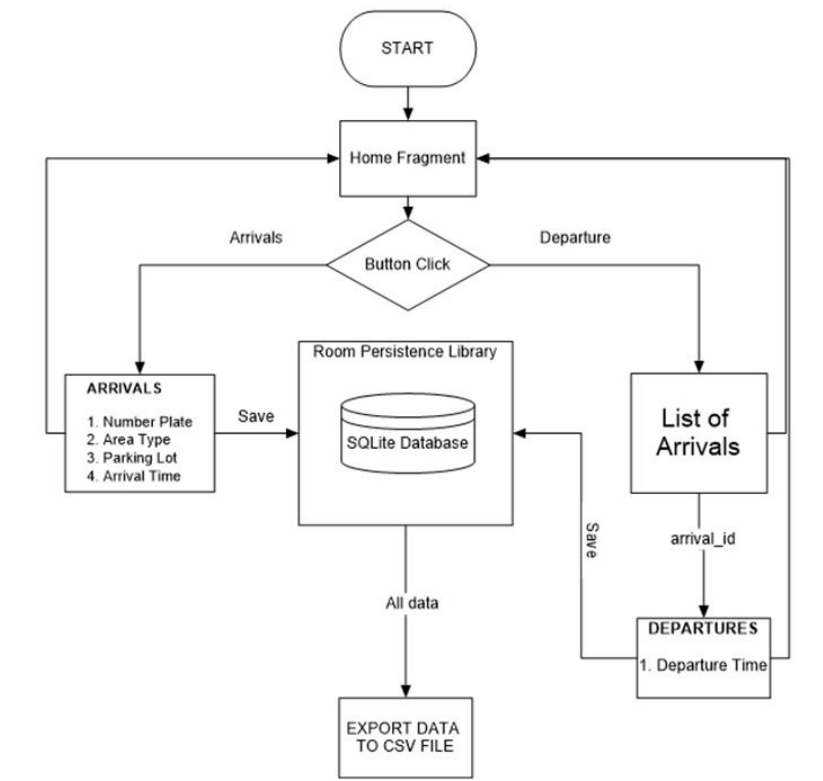
Figure 6. Parking management application